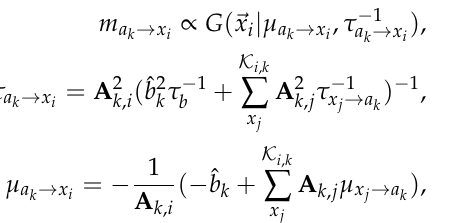
Figure 2. Actual graph structure constraining b i